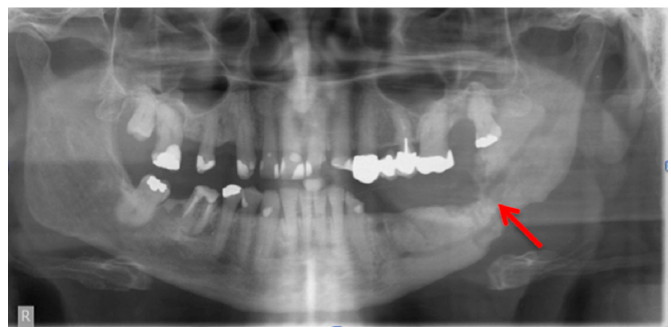
Figure 3. Panoramic radiograph: Patient: 66 years old, male, secondary osteoporosis due to castration, alendronate. Red arrow indicates the almost invisible fracture. The computed tomography (CT) scan is shown in Figure 6 and the corresponding single photon emission computed tomography (SPECT) and SPECT/CT images in Figures 8 and 9 respectively. AAMOS staging: stage 3.